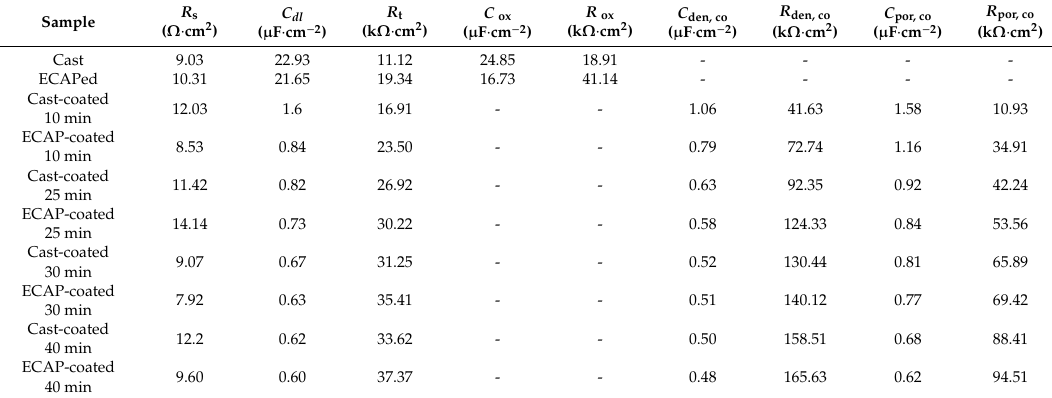
Table 1. Fitted results of the EIS spectra.